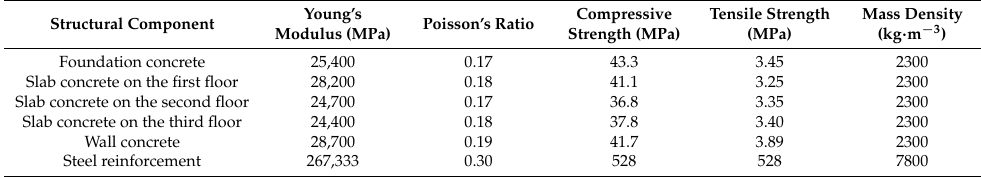
Table 2. Material properties of concrete and rebar obtained by experiments [24].